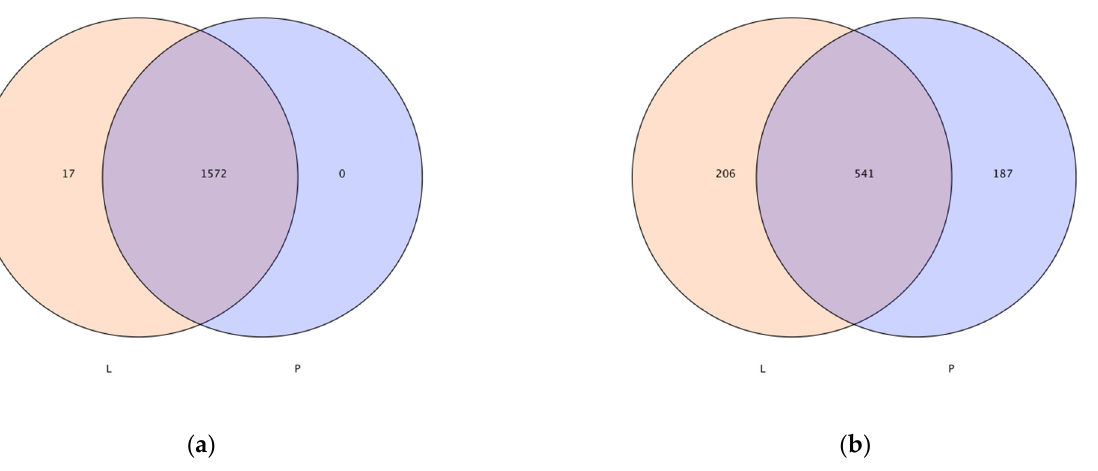
Figure 2. Venn diagrams of ( a ) bacterial and ( b ) fungal communities in soil. L: ridge tillage at two fertilizer depths; P: conventional cultivation.